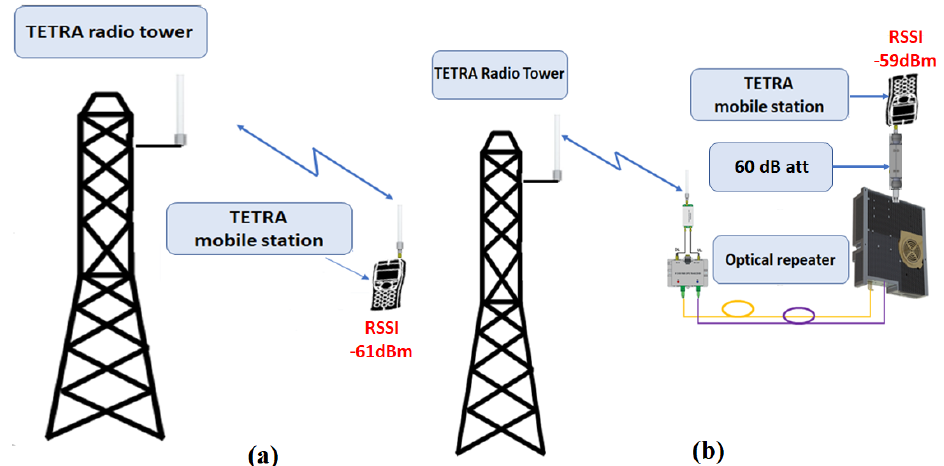
Figure 8. Gain measurement, mobile station readout: ( a ) RSSI measured at pick-up antenna; ( b ) RSSI measured at output port of the repeater with 60 dB attenuation.